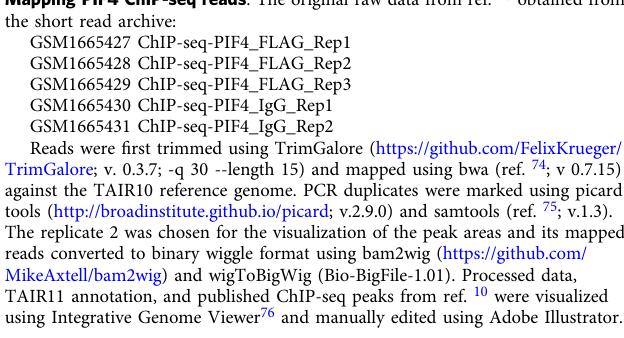
(Supplementary Table 2), synthesis of double-stranded microarray, and immuno- logical detection of DNA – protein 77 . In summary, microarrays were scanned in DNA Microarray Scanner (Agilent Technologies) at 2 μ m resolution and quanti fi ed with Feature Extraction 9.0 software (Agilent Technologies). Normalization of probe intensities and calculation of enrichment scores ( E -scores) of all the possible 8-mers were carried out with the PBM Analysis Suite 78 . Perl scripts were modi fi ed to adapt them to different custom microarray dimensions and Feature Extraction input fi les 79 . Data of MBP_PIF4-bHLH and MBP-PIF5-bHLH have been pre- viously published and are shown for comparison 8